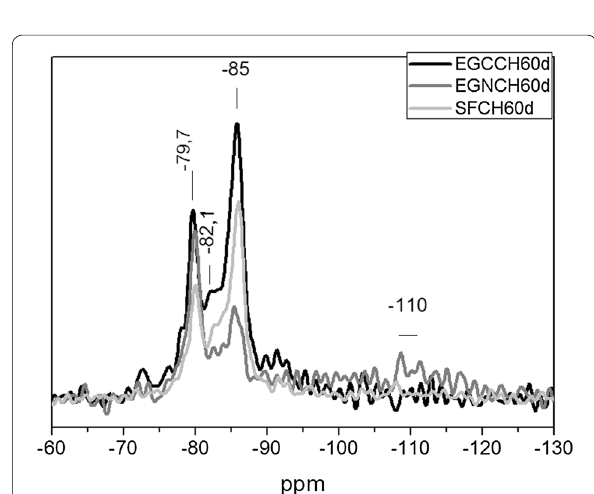
Fig. 4 29 Si NMR spectra for 60‑day blended